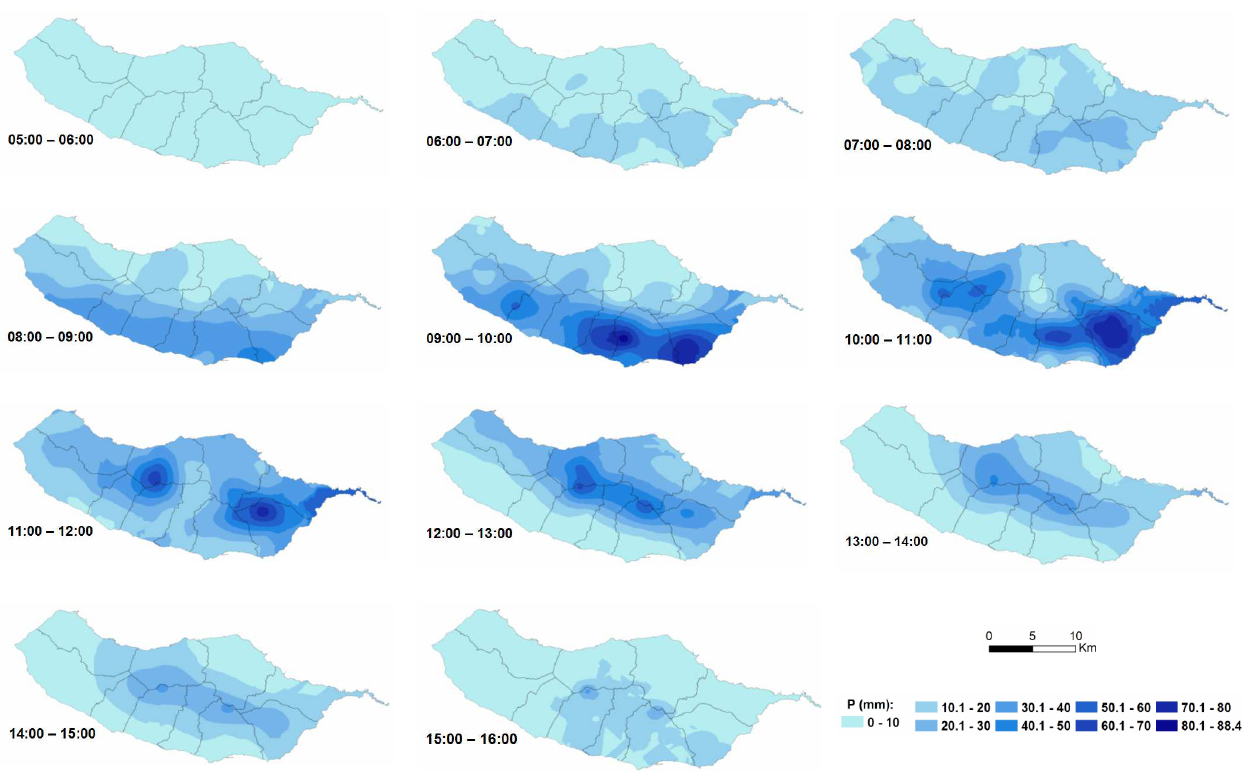
Fig. 4. Hourly precipitation in Madeira, 20 February 2010, between 05:00UTC and 16:00UTC. The maps are based on data from the same rain-gauge network represented in Fig. 1 (locations) and listed in Table 2.